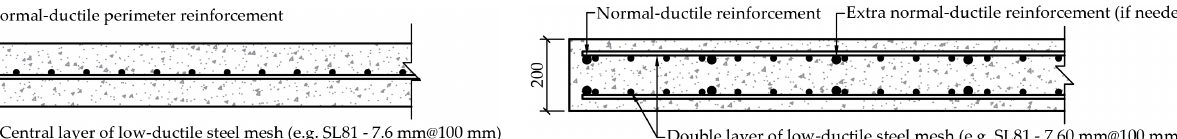
Figure 1. Two examples of reinforcement detailing in lightly reinforced precast panels typically found in Australia (corrugated ducts and connection reinforcement not shown). ( a ) Centrally reinforced precast wall. ( b ) Doubly reinforced precast wall.